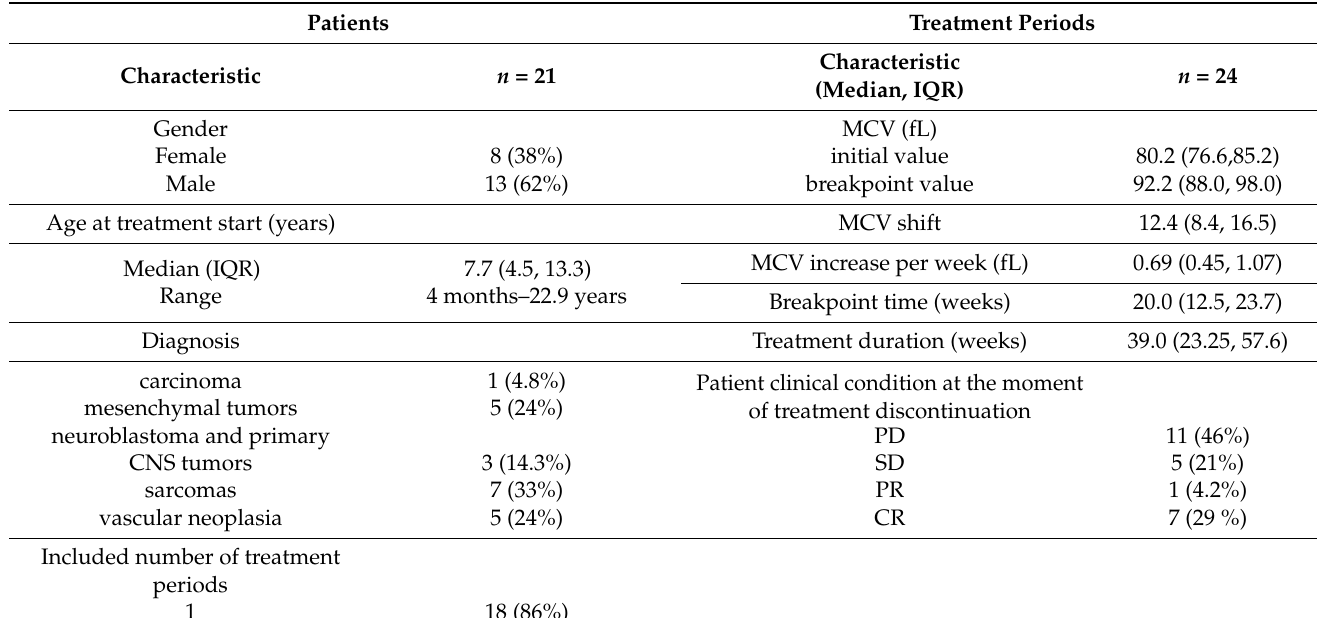
Table 5. Patient (left) and treatment period (right) characteristics and observed parameters of MCV time-courses of pediatric cohort.